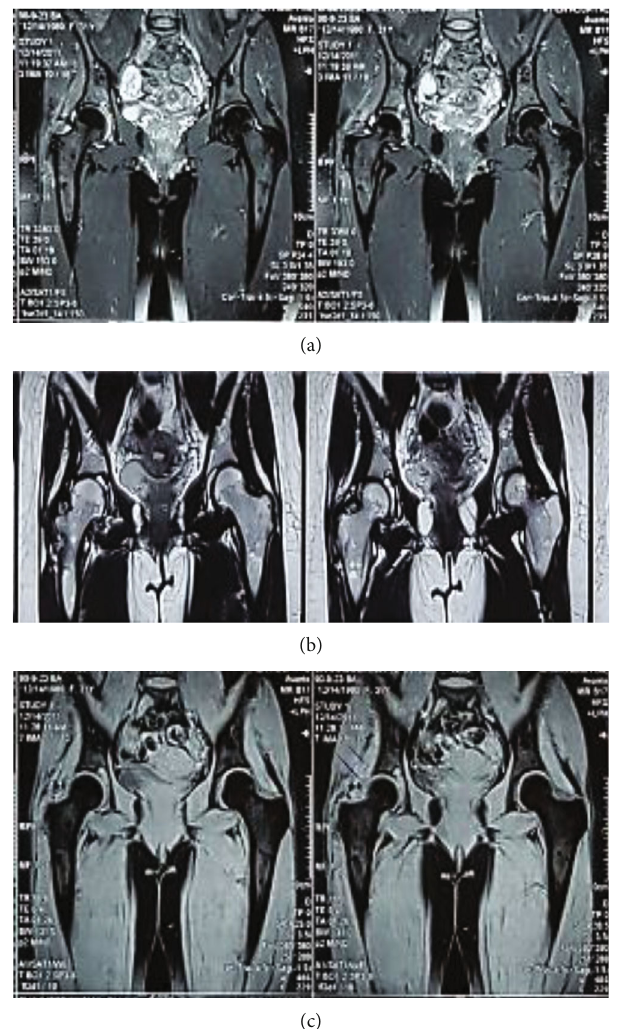
Figure 5: Proton density-weighted (a) MRI of the hip showing normal condition of the hip cleared from any abnormal lesion in a 6-year- follow-up visit. Postoperative 9-year follow-up T2 (b) and fat-suppressed (c) coronal MRI of the hip showing no lesion recurrence in the right hip synovial